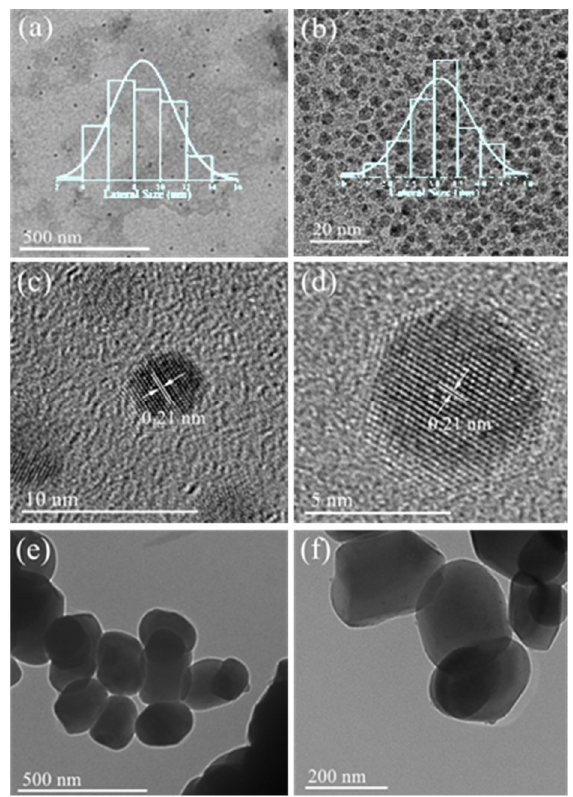
Figure 1. TEM images of GQDs ( a ), N-GQDs-50 ( b ), TiO 2 ( e ) and N-GQDs/TiO 2 -50 ( f ), insets are of corresponding lateral size distribution. HRTEM images of GQDs ( c ) and N-GQDs-50 ( d ).